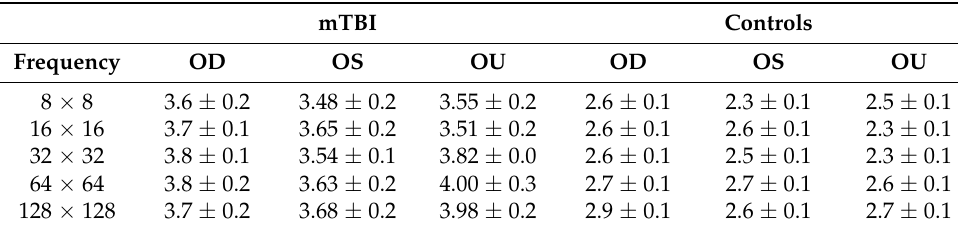
Table 5. PSD mean and standard error values, (a) TBI values, (b) and controls. mTBI Controls